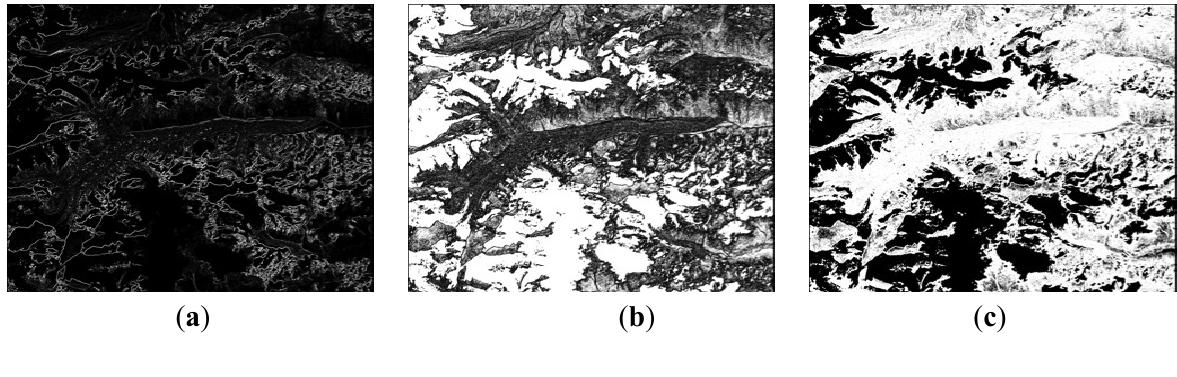
Figure 12. Three co-occurrence grey level measures derived from PC1 of the subset image (all with a 3 × 3 moving window: ( a ) variance; ( b ) homogeneity; ( c )